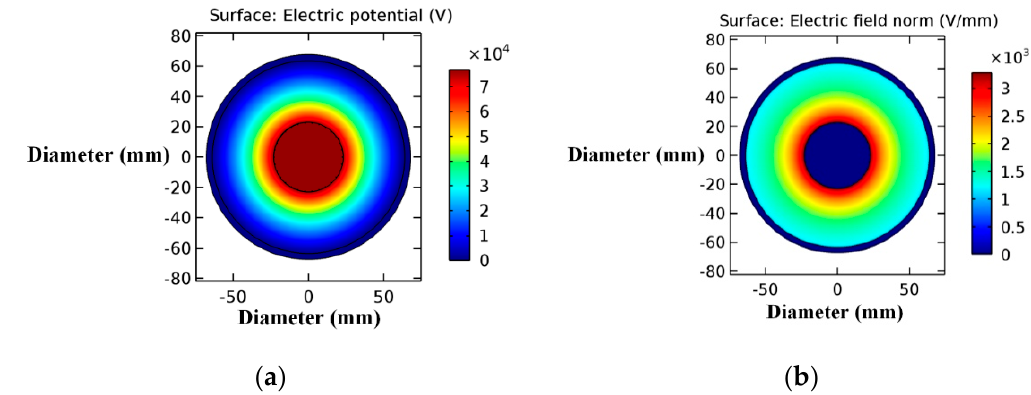
Figure 9. ( a ) Potential difference and ( b ) field distribution apropos of the proposed pliable GIL regarding specimen 3 of Table 3.